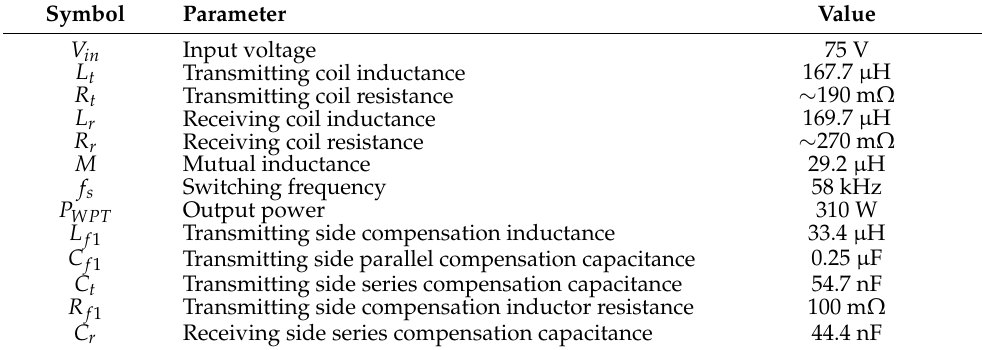
Table 1. Wireless charger parameters.